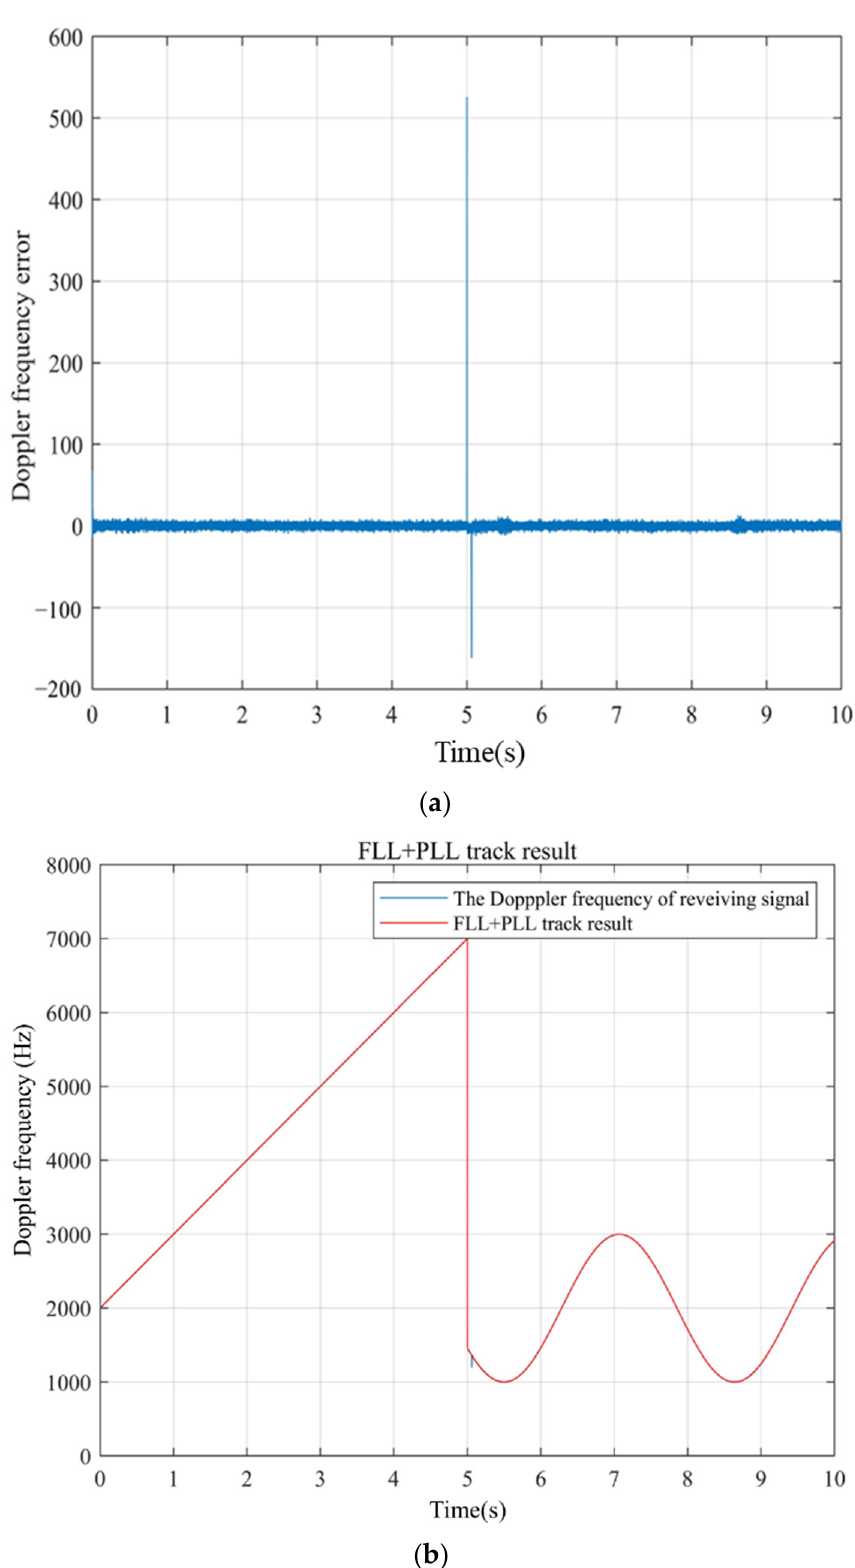
Figure 13. The switching time when α : β = 0.3 : 0.7 and C / N 0 = 65 dB-Hz. ( a ) the Doppler frequency error, and ( b ) the Doppler frequency measurement.